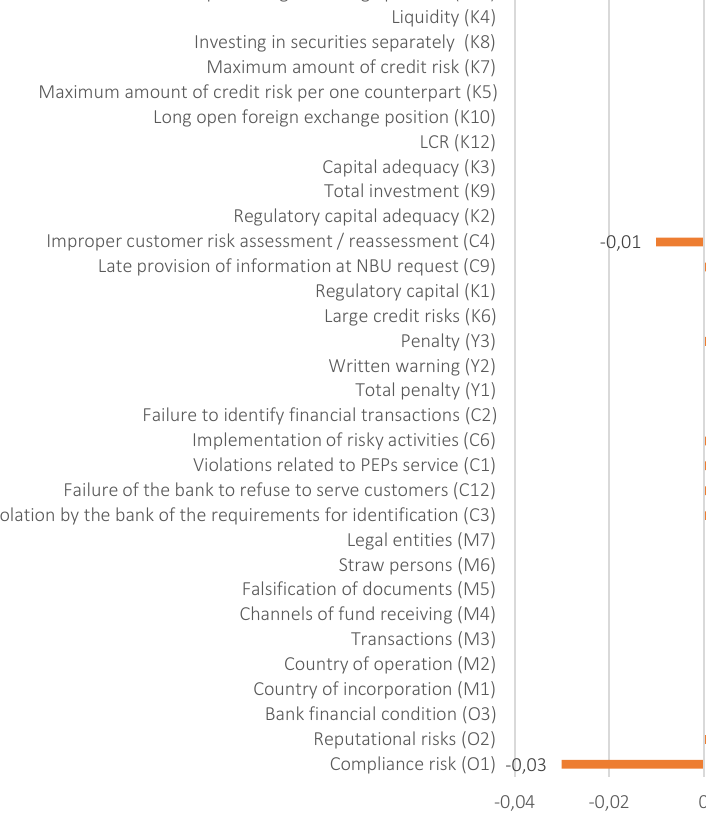
Figure 1. Forecasted variability of compliance indicators and expectations of the bank’s counterparties in the field of non-state pension in response to the change in the amount of